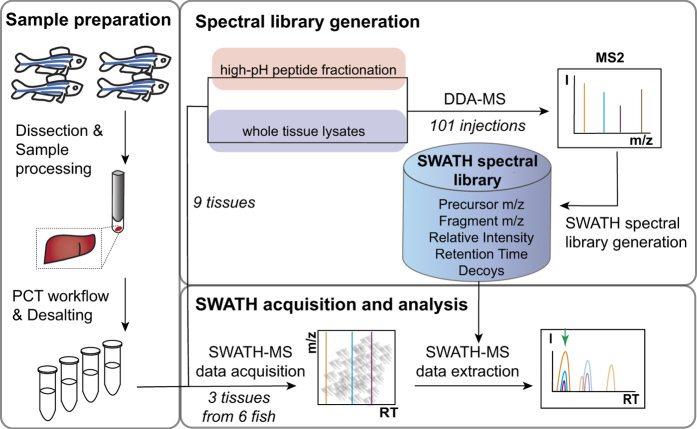
Workflow of creating and using the SWATH spectral library.Samples were prepared using the pressure-cycling (PCT) workflow24. The spectral library was built from fragment ion spectra generated by data-dependent acquisition mass spectrometry (DDA-MS) from fractionated and unfractionated peptide samples11. The spectral library was then used to analyze samples from 3 different tissues using the OpenSWATH workflow12.